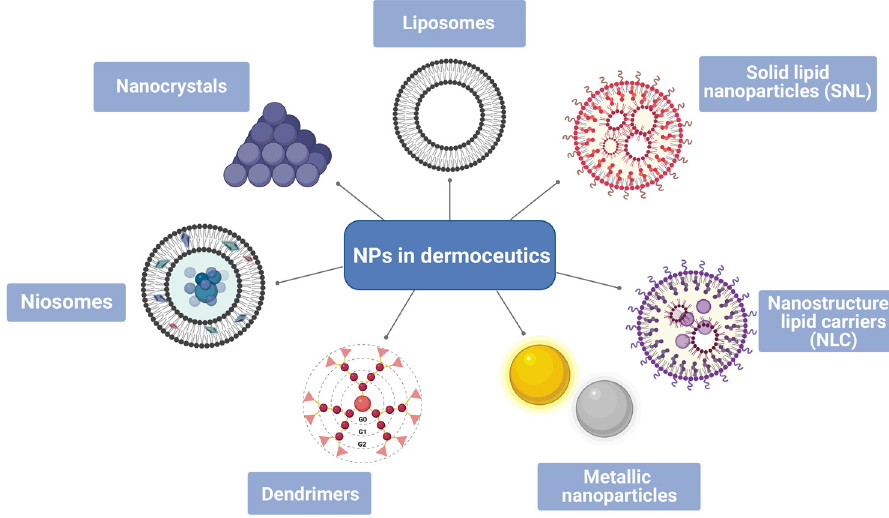
Figure 3: NPs used in developing dermoceutics. Created by